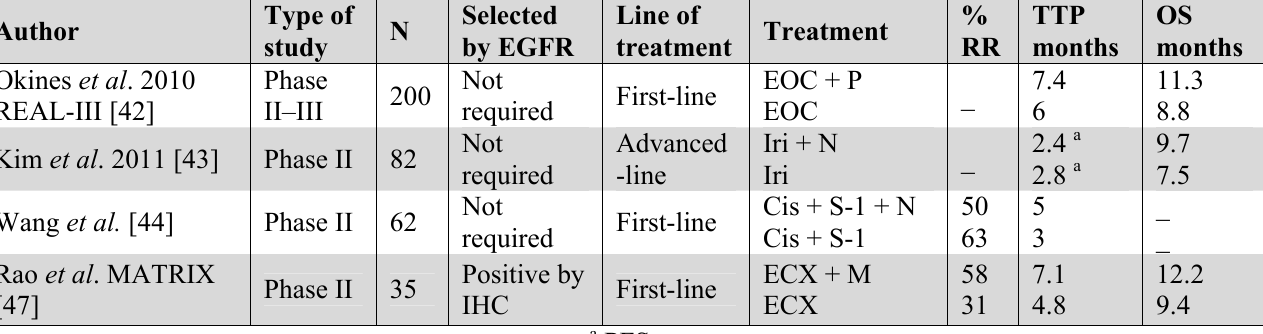
Table 3. Clinical Trials with anti-EGFR agents (non-cetuximab) in advanced GC and GEJ